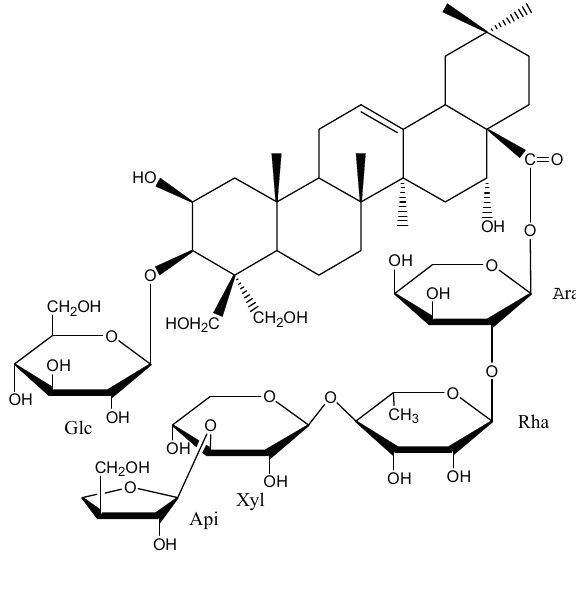
Figure 1. The chemical structure of platycodin D (C 57 H 92 O 28 , M.W. 1225).